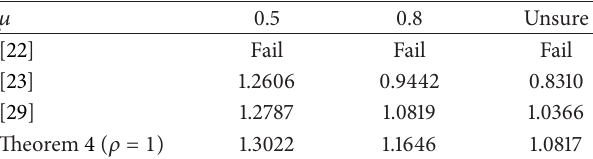
Table 2: Allowable upper bound of 𝜏 for variable 𝜇 and 𝑘 = 0.8